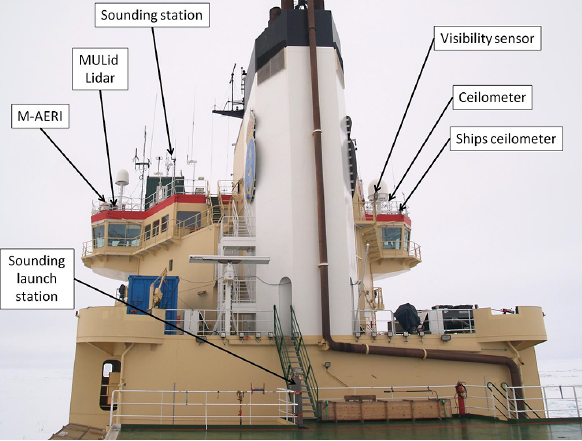
Fig. 9. Photograph of the “Open Lead” site showing the location of the various sensor systems away from Oden .